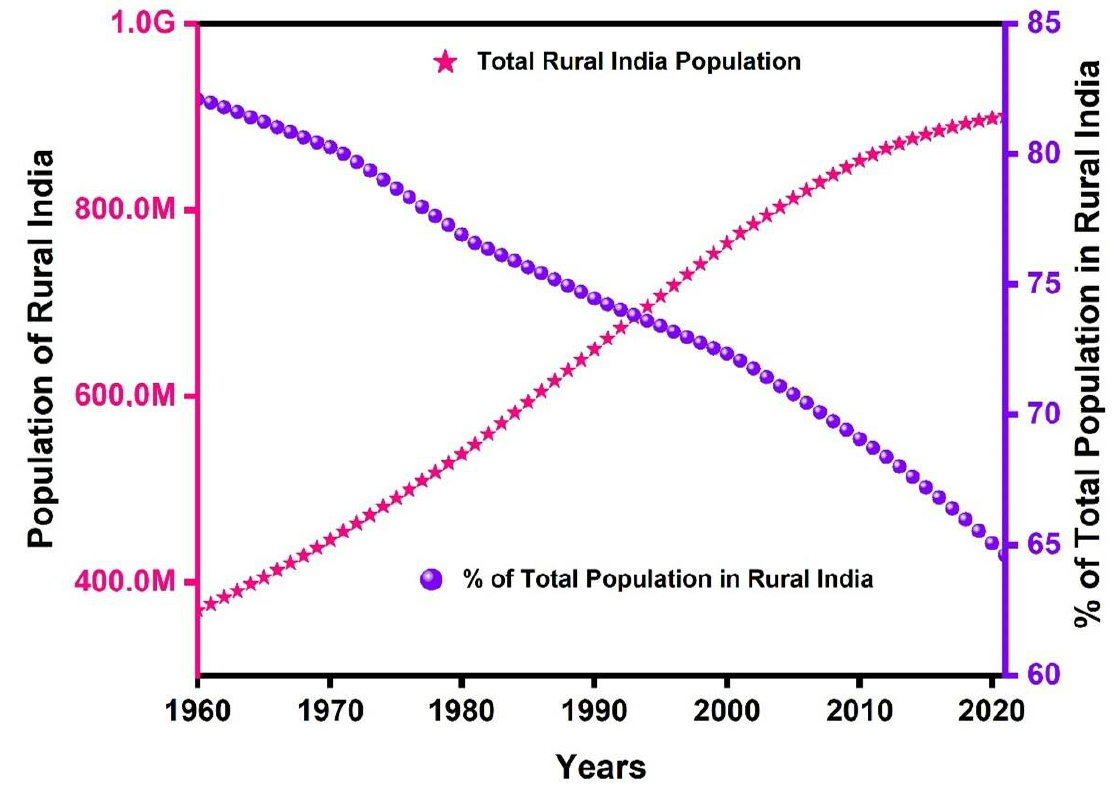
Figure 1. World Bank estimate: India’s rural population growth as a function of years (left scale) (‘M’ = 10 6 and ‘G’ = 10 9 ), expressed as the percentage of the total population in rural India (right scale). The data used in this Figure 1 are extracted from the World Bank estimates based on the United Nations Population Division’s World urbanization prospects: 2018 Revision